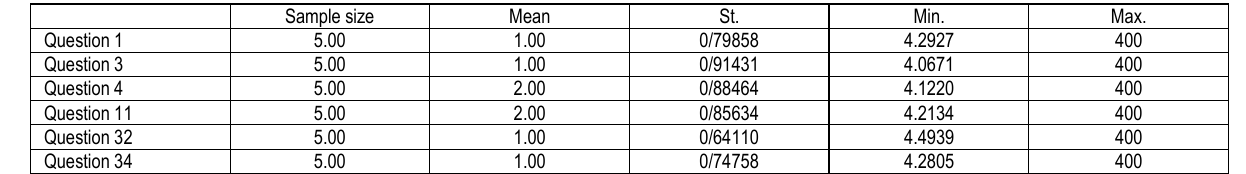
Table 10. Results of descriptive statistics (accountability factors)